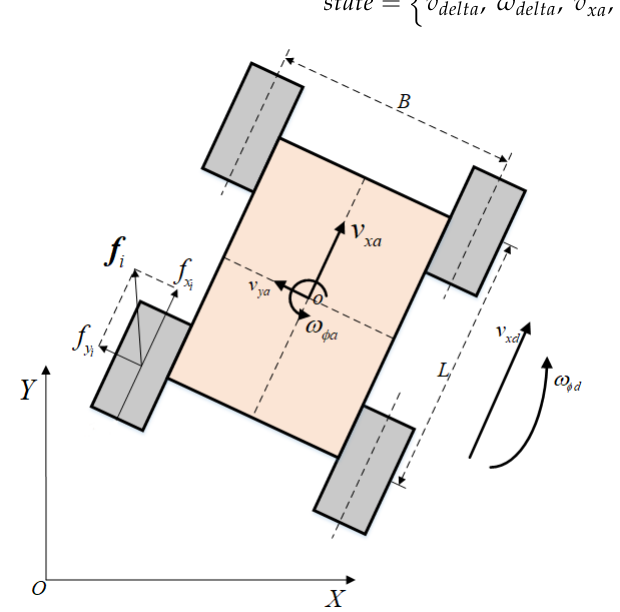
Figure 1. Skid-steering vehicle